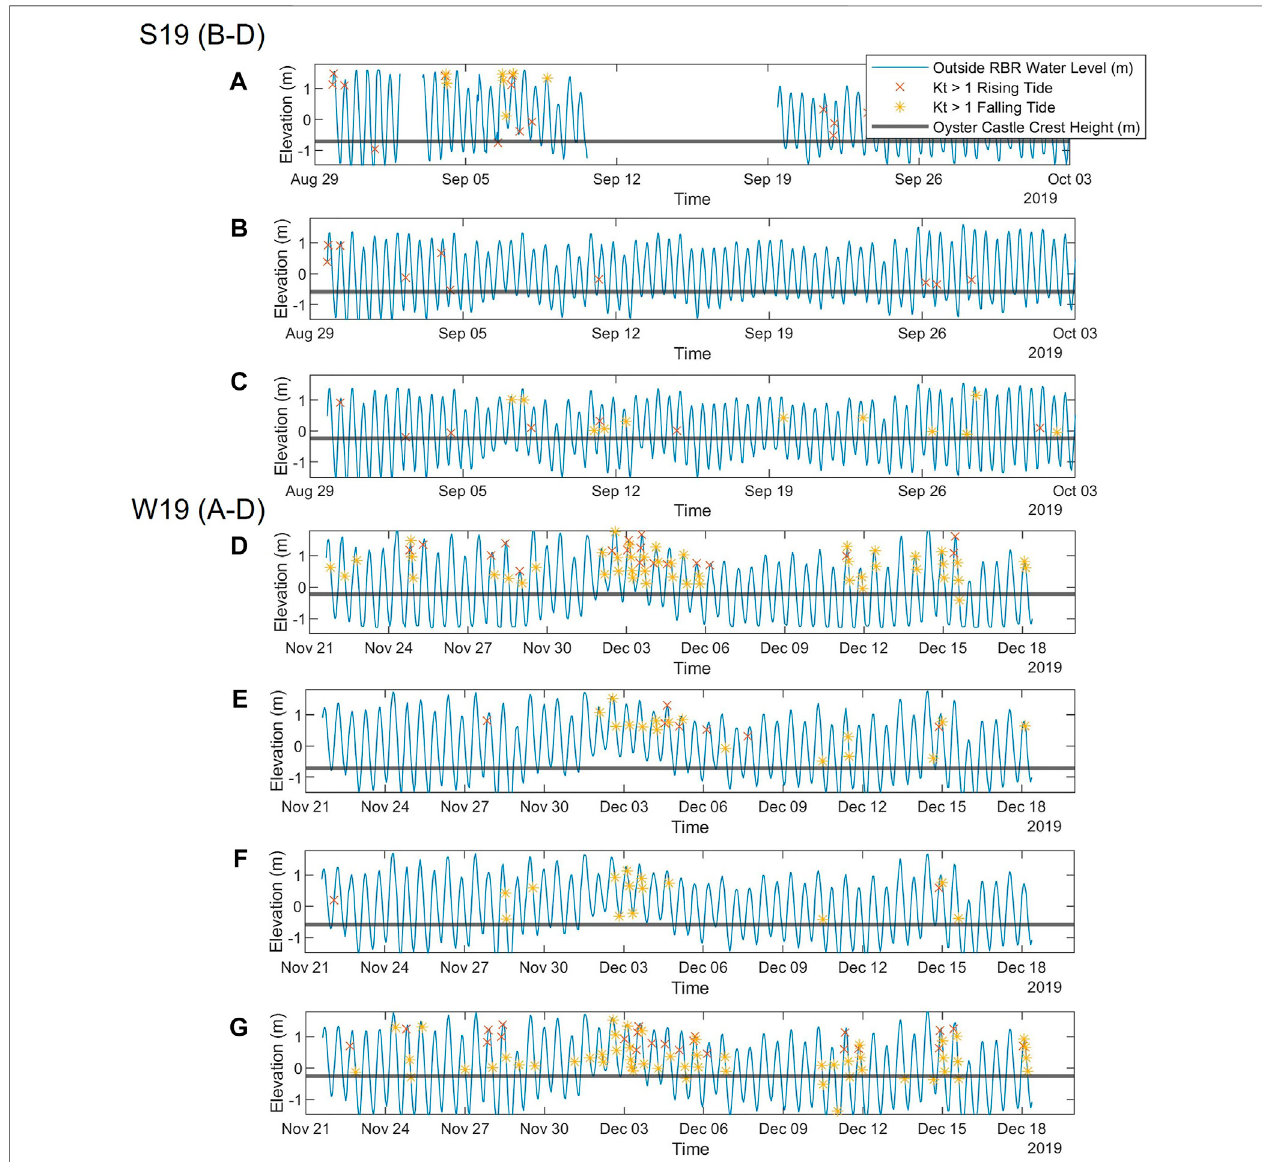
FIGURE 4 | Water levels during S19 (A – C) and W19 (D – G) at Site A (D) , B (A,E) , C (B,F) , and D (C,G) . Ampli fi cated wave height ( K t > 1) is indicated by stars and x ’ s. Yellow stars and red x ’ s indicate if ampli fi cation is on the falling or rising tide, respectively. The bold horizontal line indicates the Oyster Castle crest elevation at that